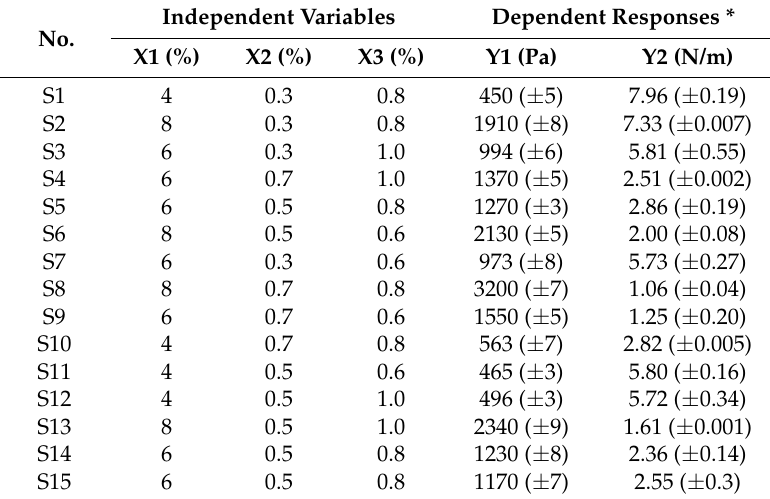
Table 2. Experimental design and results of the felbinac